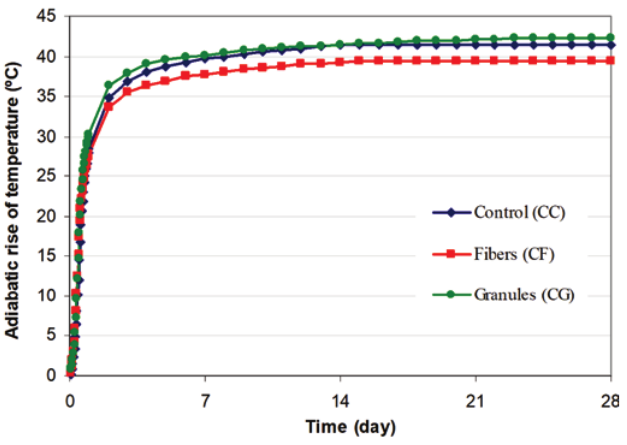
Experimental data points and best-fit curve of the Young's modulus evolution over time for each type of